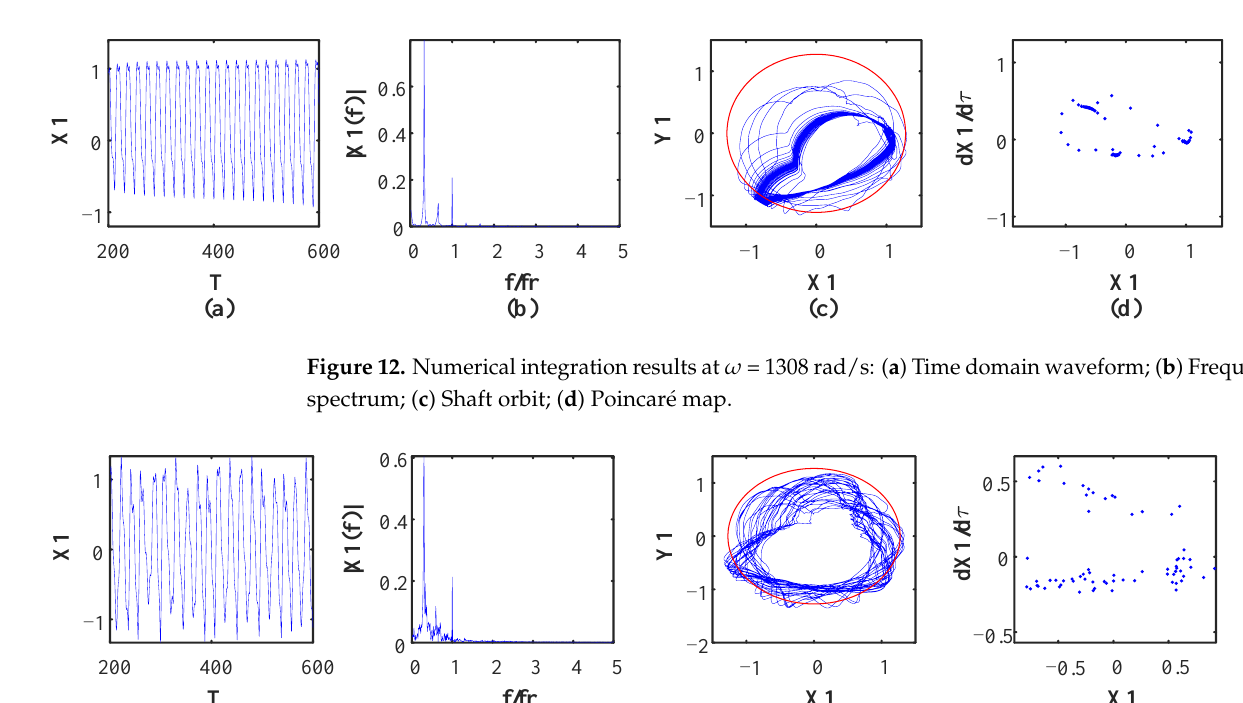
Figure 11. Numerical integration results at ω = 1190 rad/s: ( a ) Time domain waveform; ( b ) Frequency spectrum; ( c ) Shaft orbit; ( d ) Poincaré map.